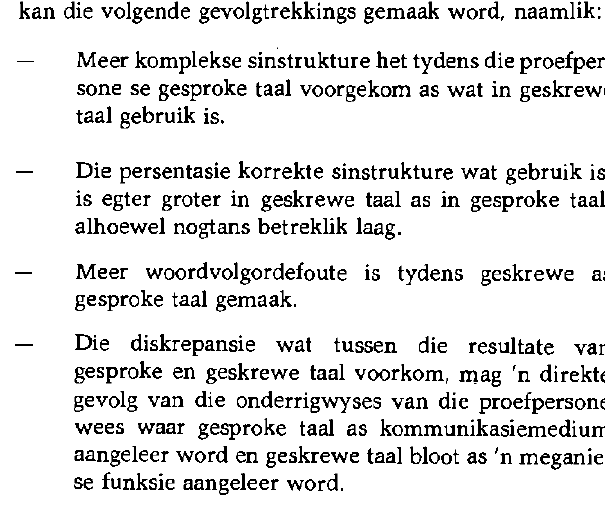
Kretschmer en Kretschmer (1978) se bevinding dat die gehoorgestremde kind min komplekse sinstrukture in gesproke en geskrewe taal gebruik, ondersteun dus die resultate van hierdie studie.